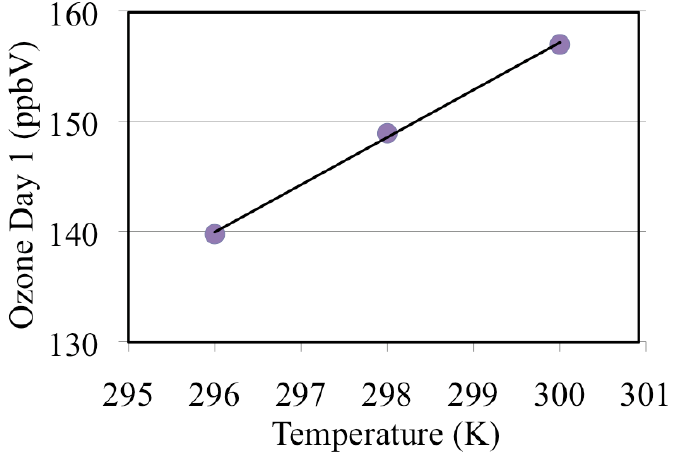
mixing ratios on the first day as a function of temperature for the Figure 23. Maximum O 3 polluted urban atmosphere